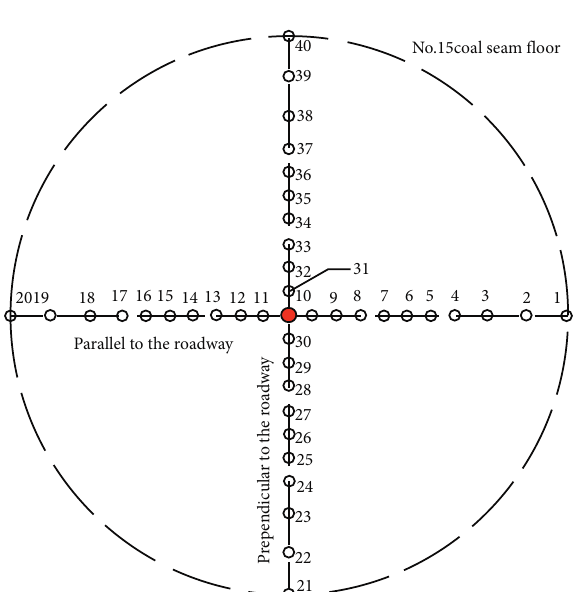
Figure 6: Schematic diagram of the observation hole number of the pressure holding hole.